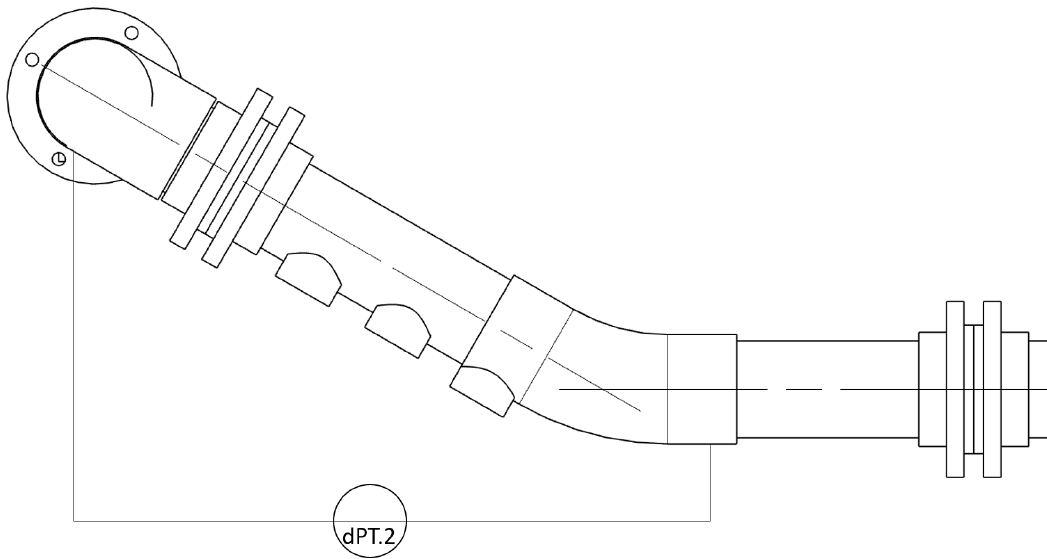
Figure 3. dPT.2 installation.